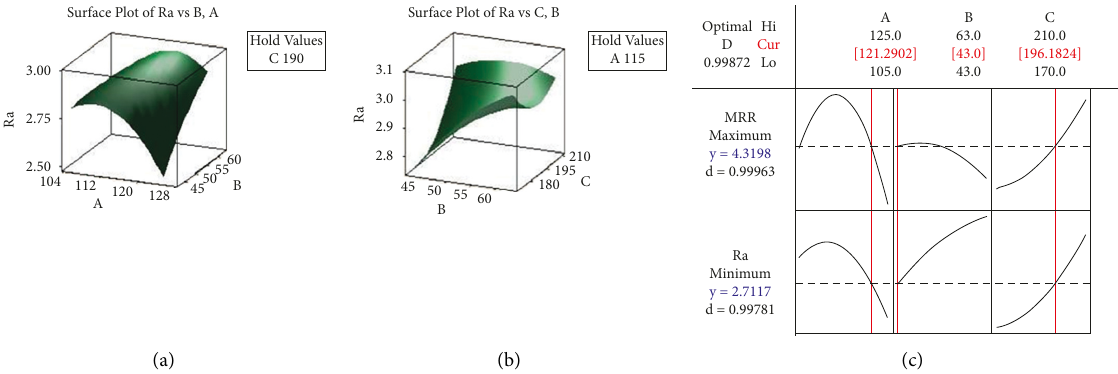
Surface Plot of Ra vs B, A